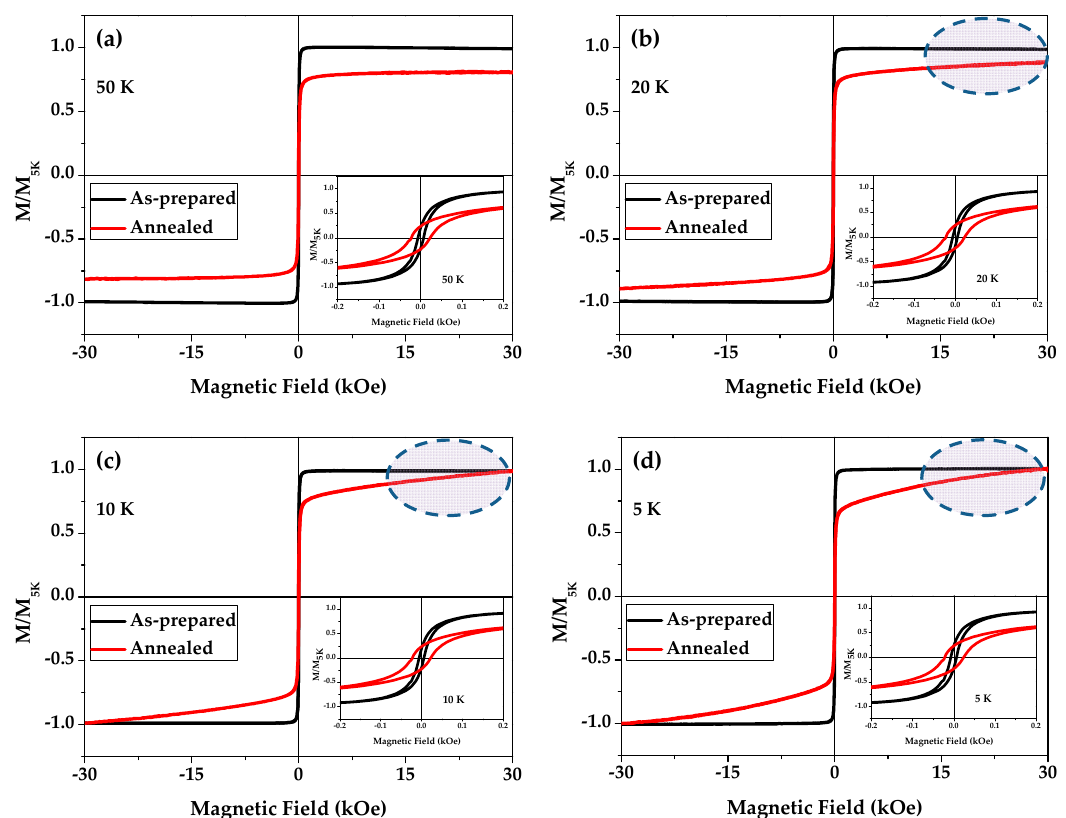
Figure 4. Co 2 MnSi glass-coated microwire magnetization curves (M/M 5K ) for as-prepared samples (black loops) and samples annealed at 1023 K for 2 h (red loops) measured under a maximum field of 30 kOe and at different temperatures (from 50 K to 5 K). The inset indicates the loops with low scale of the applied magnetic field.